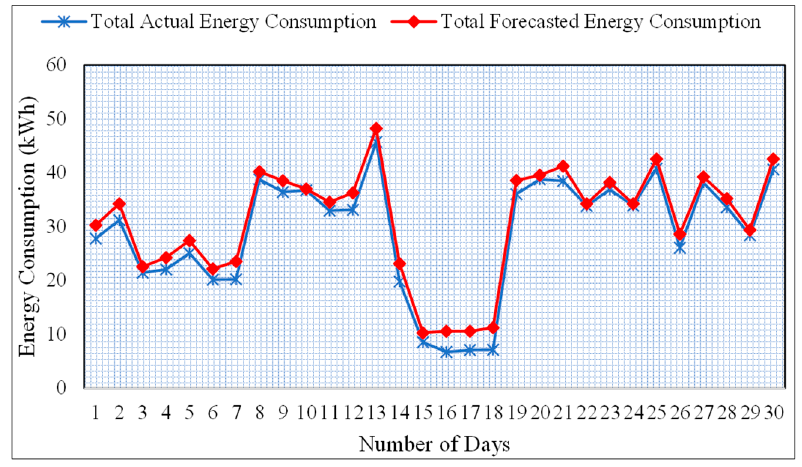
Figure 7. Comparison of forecasted and actual energy consumption of smart meter # MAC00050.